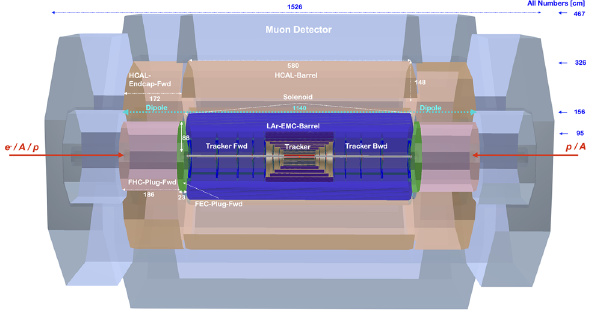
Fig. 24 SideviewofafirstdesignoftheLHeCdetectorforboth eh and hh collisions, where the detector coverage of the backward (electron) direction is extended to match that for the forward (hadron) direction. The overall size in beam direction increased from 13.75 to 15.26m while the diameter is unchanged as compared to the new eh detector version presented